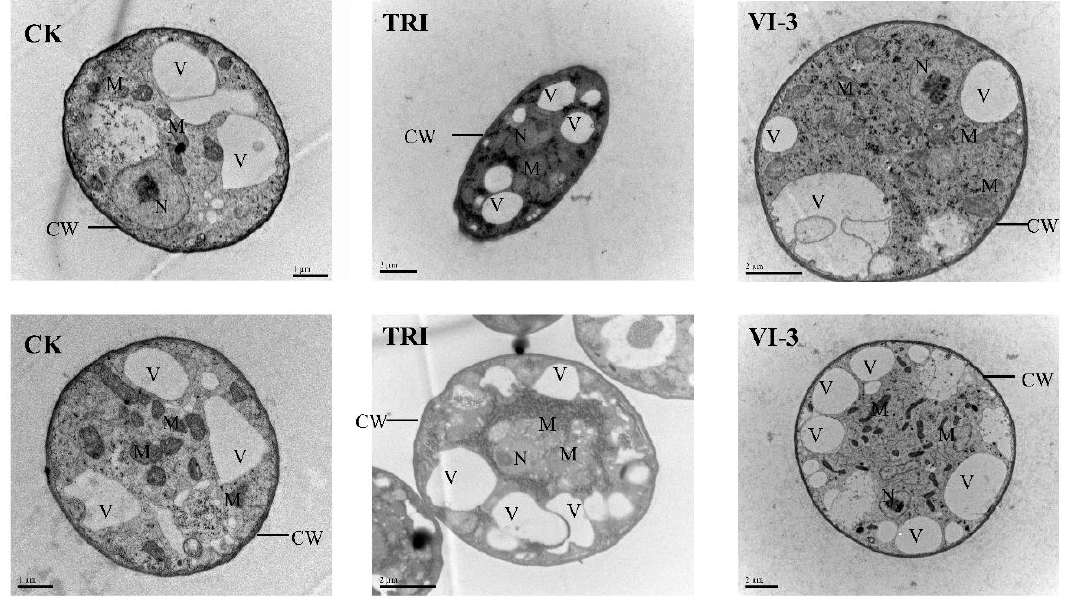
Figure 2. The cell variance of S. sclerotiorum treated with VI - 3 and TRI observed by TEM. Note: CW: cell wall; N: nucleus; M: mitochondrion; V: vacuole.